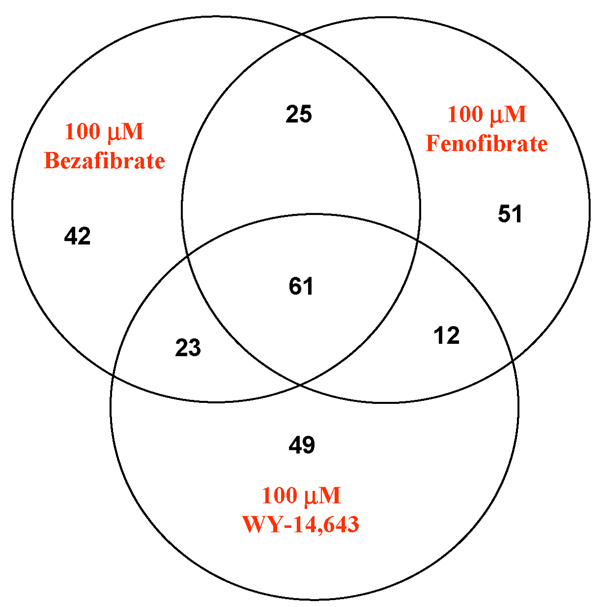
Distribution and overlap of significant genes (fc > 1.5 and p < 0.05) among bezafibrate fenofibrate and WY-14,643 treatments of 100 μM.